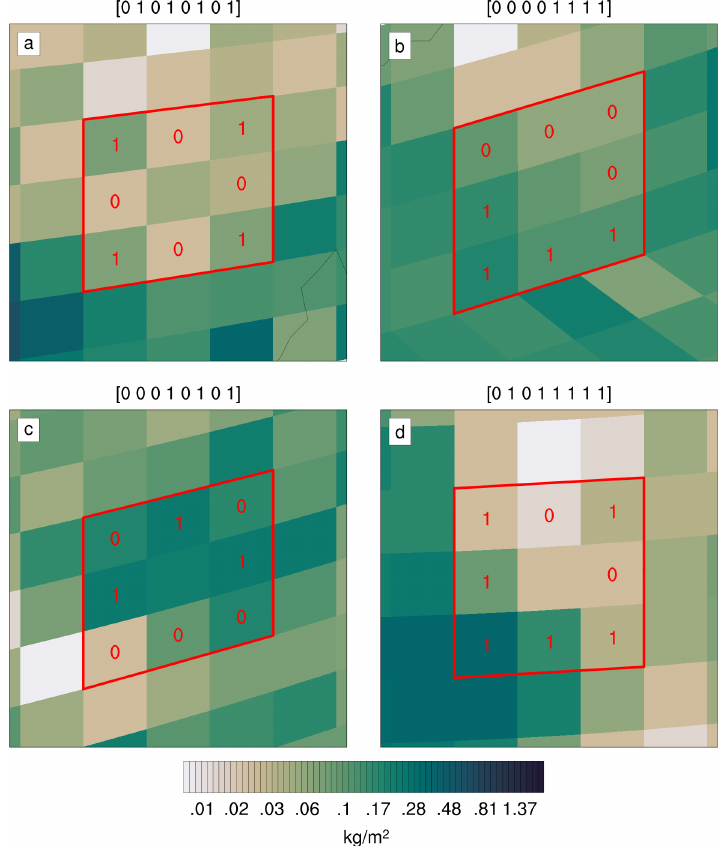
Figure 4. Examples of the patterns identified in daily snapshots of liquid water path from E3SM-MMF corresponding to the pattern examples in Table 1. Cells are labeled with a “0” for values less than or equal to the center value and “1” otherwise. Note that a logarithmic spacing is used for the color